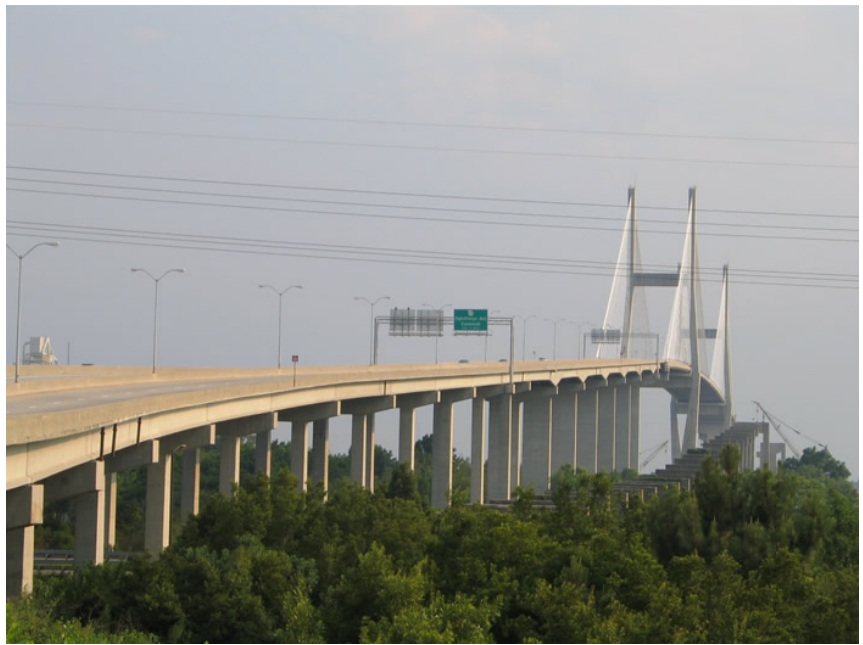
Figure 2. Talmadge Bridge [19].